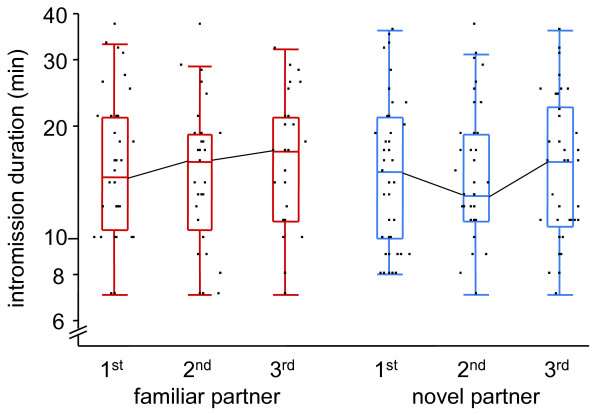
Penis intromission durations across the three consecutive mating trials within novel and familiar partner treatments. See Fig. 2 and Table 1 for display and statistics, respectively.